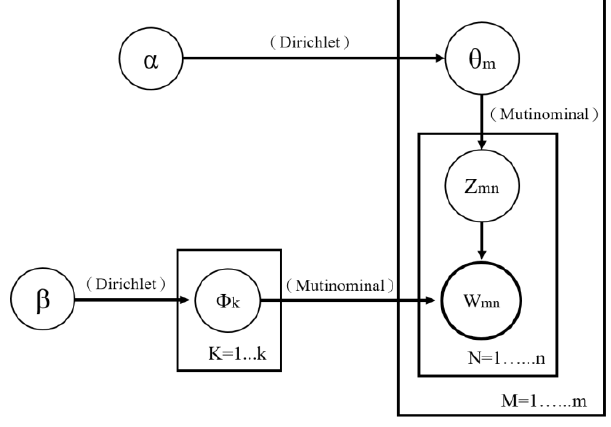
Figure 2. LDA model